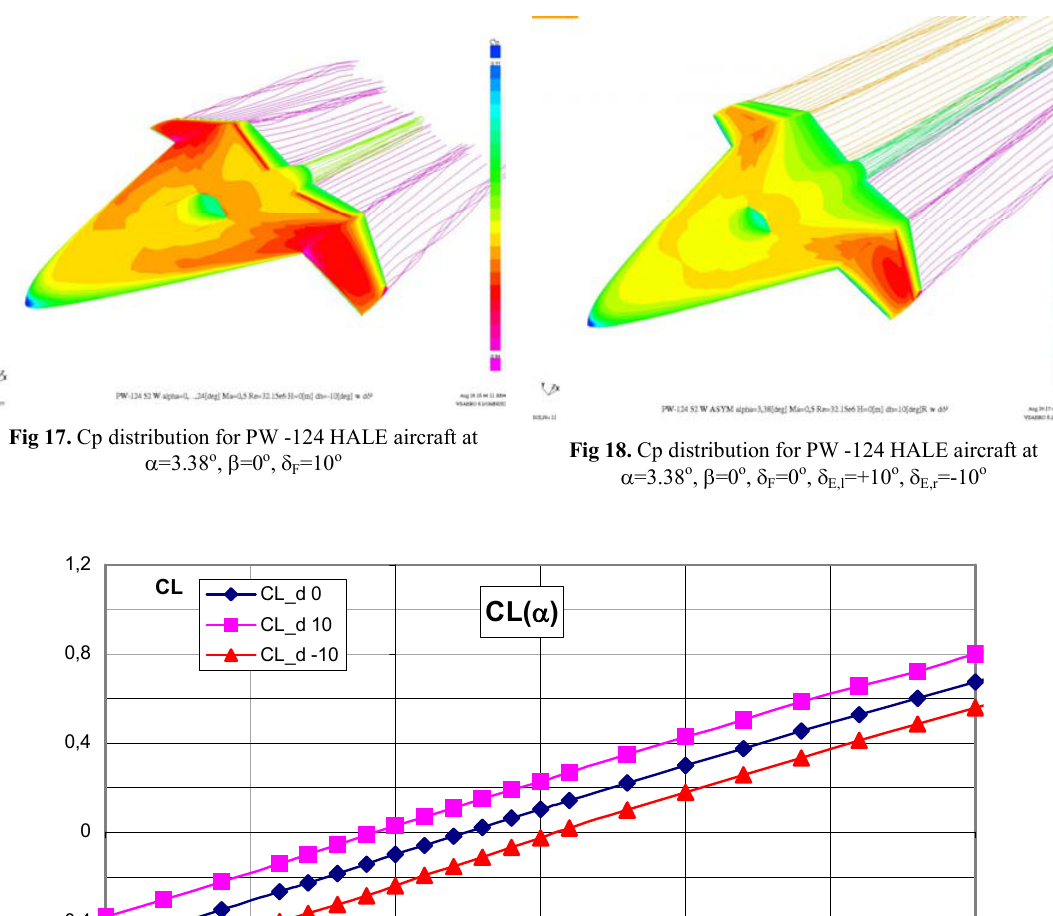
Fig 15. Cp distribution for PW-124 aircraft at a =10 o